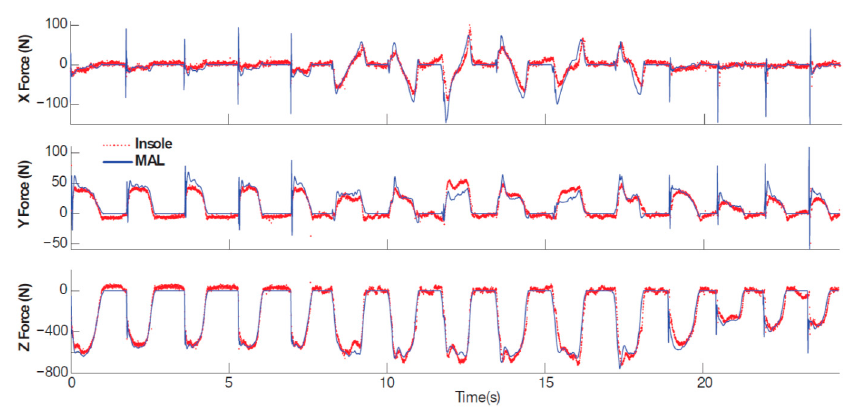
Figure 20. Comparison of A-P (X), M-L (Y) and vertical (Z) GRF measured by insole (red dots) with corresponding force-plate data (blue line) (after [104]).